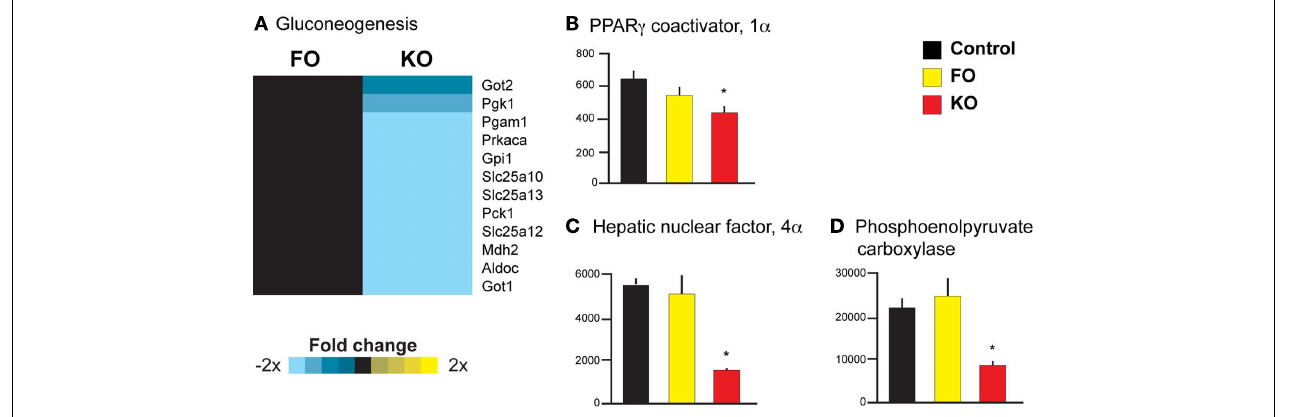
FIGURE 3 | Gene expression heatmap and transcriptional regulators of gluconeogenesis. Pathway analysis revealed a significant downregulation of the Reactome pathway “Gluconeogenesis” by KO (A) . In addition, only KO significantly decreased the expression of genes regulating hepatic gluconeogenesis, including Ppargc1a (B) , Hnf4a (C) , and Pck1 (D) .